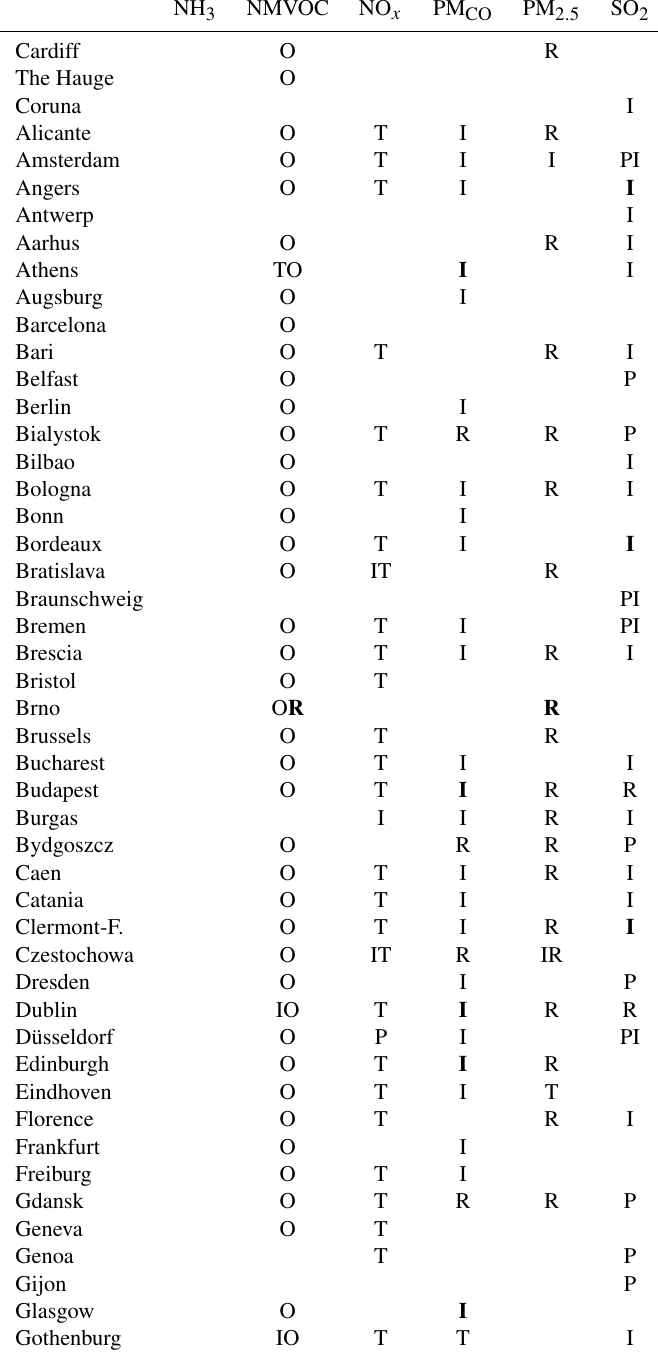
Table A1. Details of the screening output for the 150 cities, 6 emitted pollutants (NH 3 , NMVOC, NO x , PM CO , PM 2 . 5 , and SO 2 ), and 5 considered sectors (public power, residential, transport, industry, and other). In the table, sectors are represented by their first letter. Empty cells mean that no relevant emissions have been screened. Black letters indicate relevant and consistent emissions, whereas bold letters indicate relevant but inconsistent